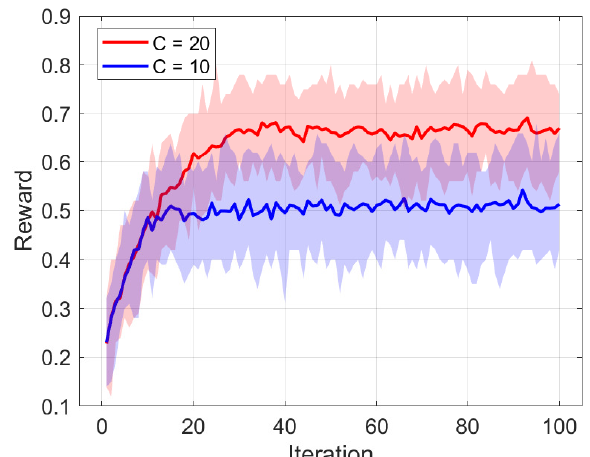
Figure 5. The rewards of the proposed scheme earned during a training process. p = 0.001, ρ = 0.5, V = 100, N = 50, K = 10, and β =